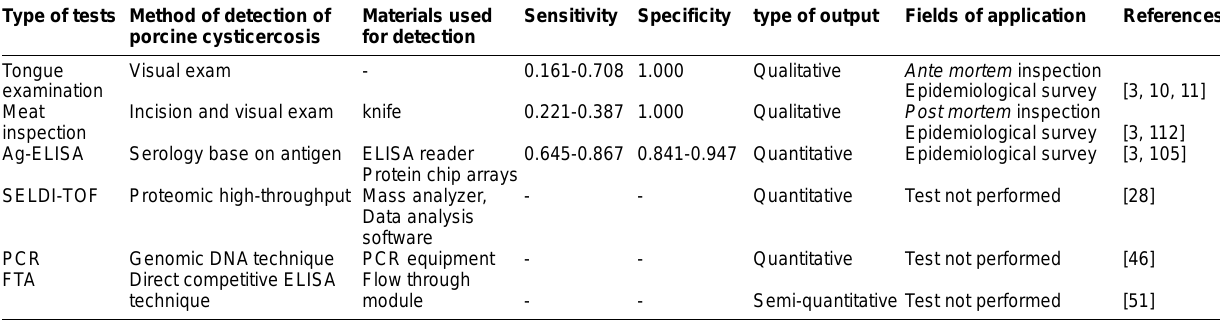
Table-1. Characteristics of porcine cysticercosis detection tests Type of tests Method of detection of